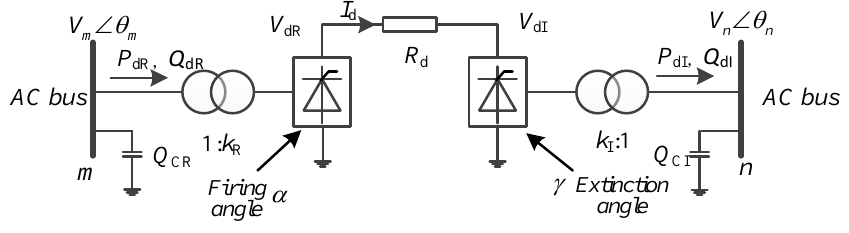
Figure 1. Diagram of HVDC system.